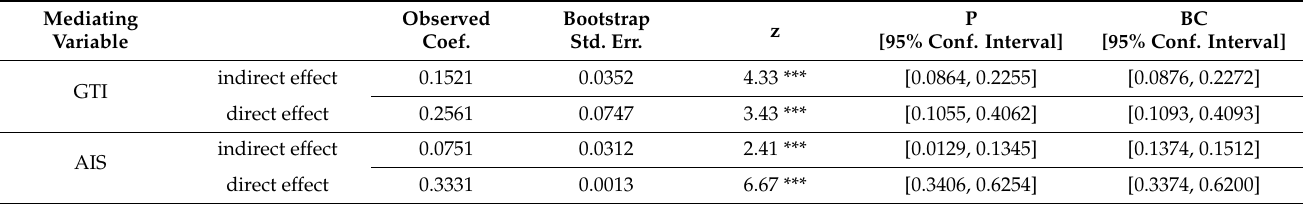
Table 4. Test results of the mediating effect of bootstrap method.